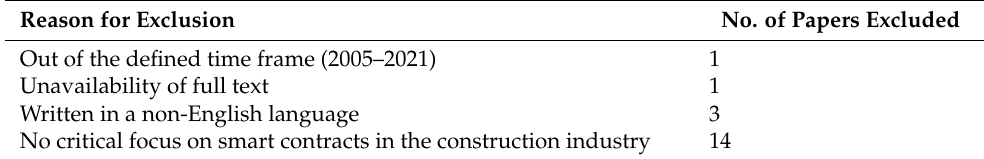
Table 2. Reasons for excluded papers in the